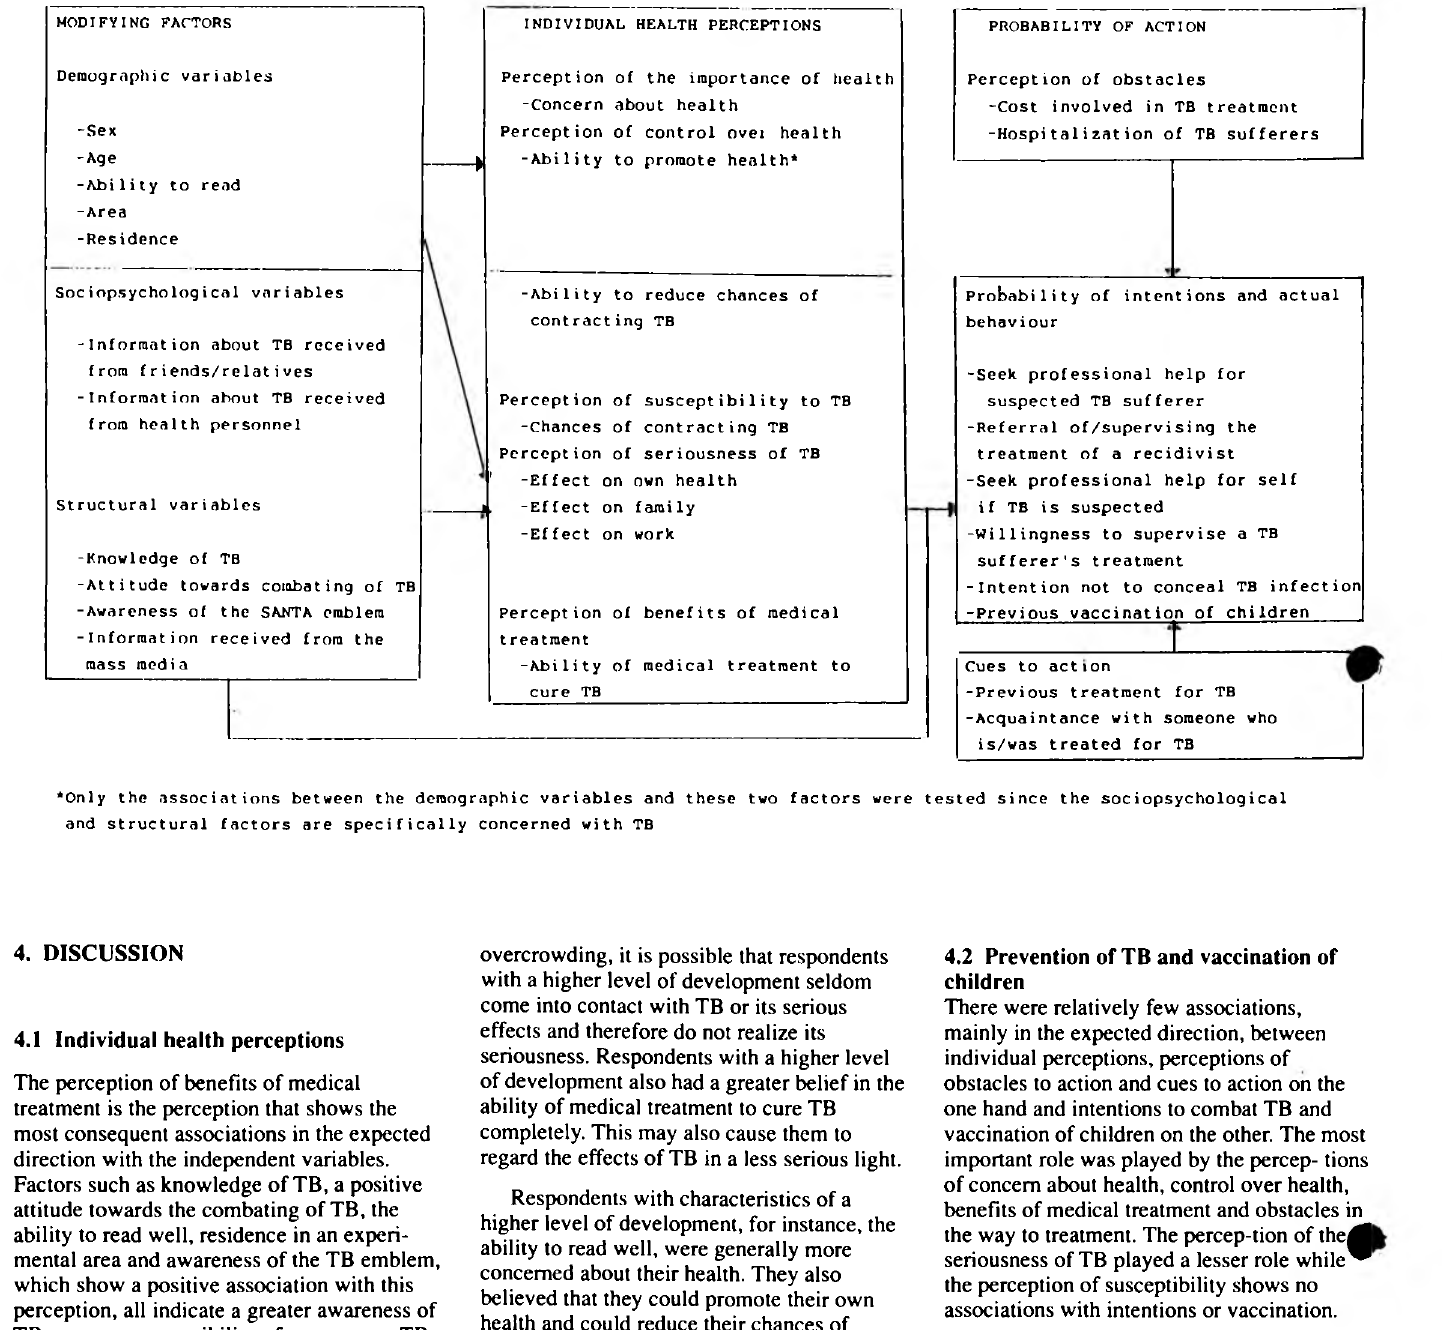
FIGURE I: HEALTH BELIEF MODEL AS ADAPTED FOR THIS